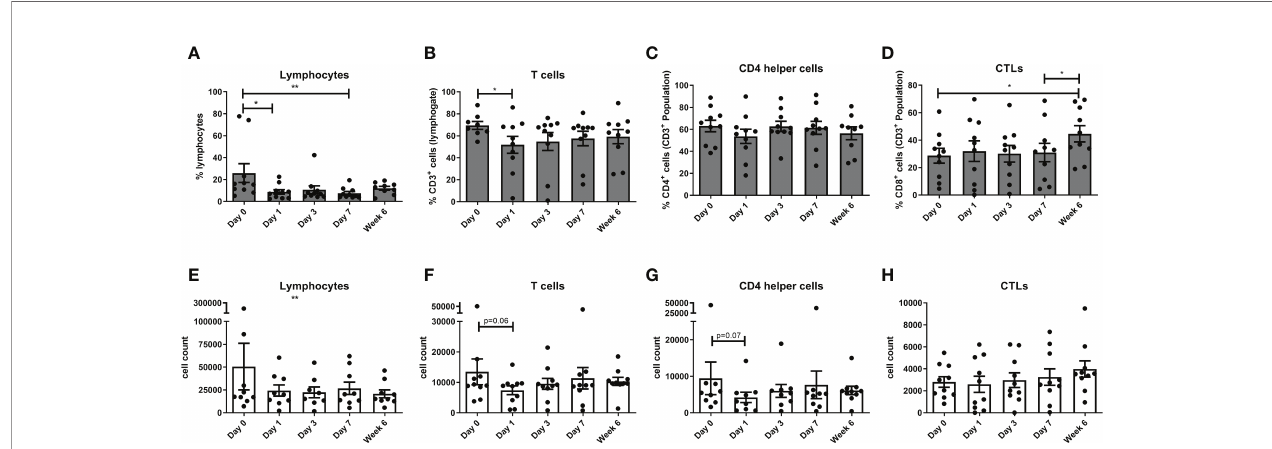
FIGURE 1 | Circulating levels of lymphocytes decrease with a concomitant increase in circulating CTLs post-operatively. The percentage of circulating lymphocytes (A, E) , T cells (B, F) , CD4 T helper cells (C, G) and CTLs (D, H) were determined by fl ow cytometry in OAC patients on the day of tumor resection prior to surgery (Day 0) and on post-operative days 1, day 3, day 7 and week 6 (n=11). (A – D) displays the frequency of cell types and (E – H) depicts the cell counts for each cell type in peripheral circulation at each longitudinal time point. Paired, non-parametric t-test *p<0.05 and